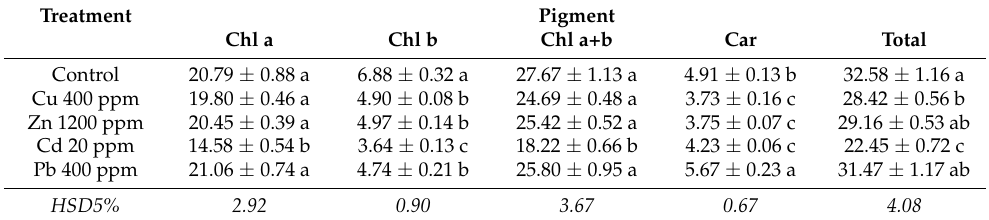
Table 2. Photosynthetic pigments in S. perfoliatum leaves under different treatments.